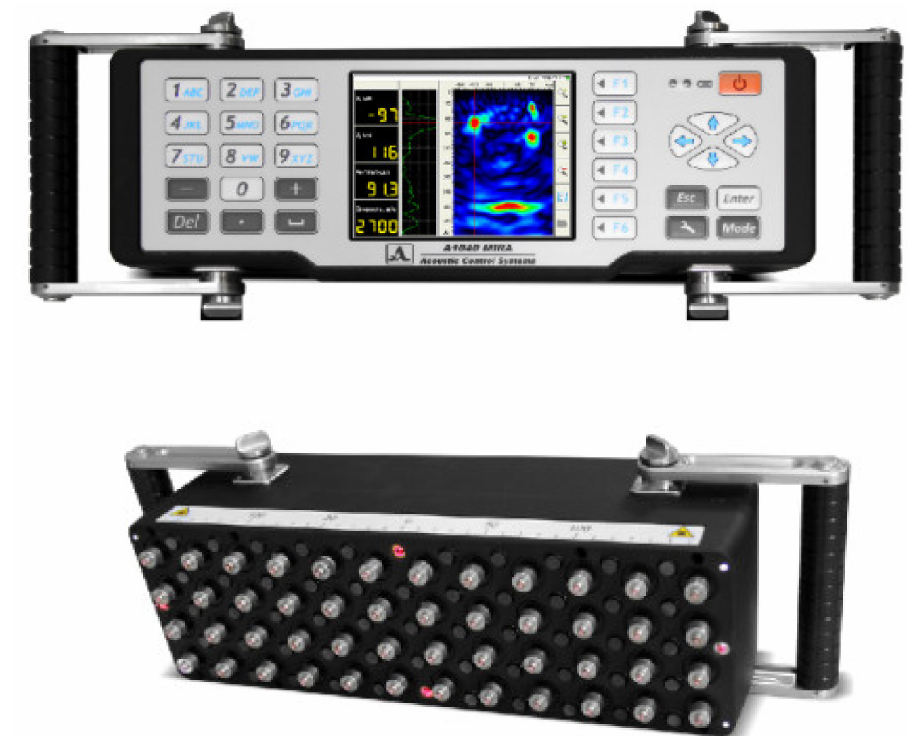
Figure 1. Ultrasonic tomograph: top and bottom view.